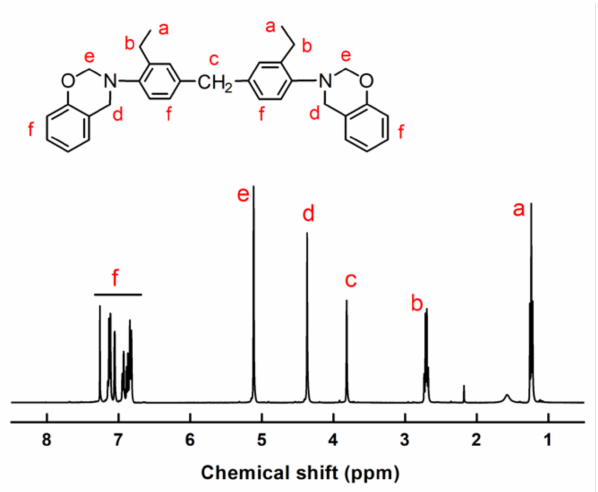
Figure 1. 1 HNMR spectrum of MOEA-BOZ